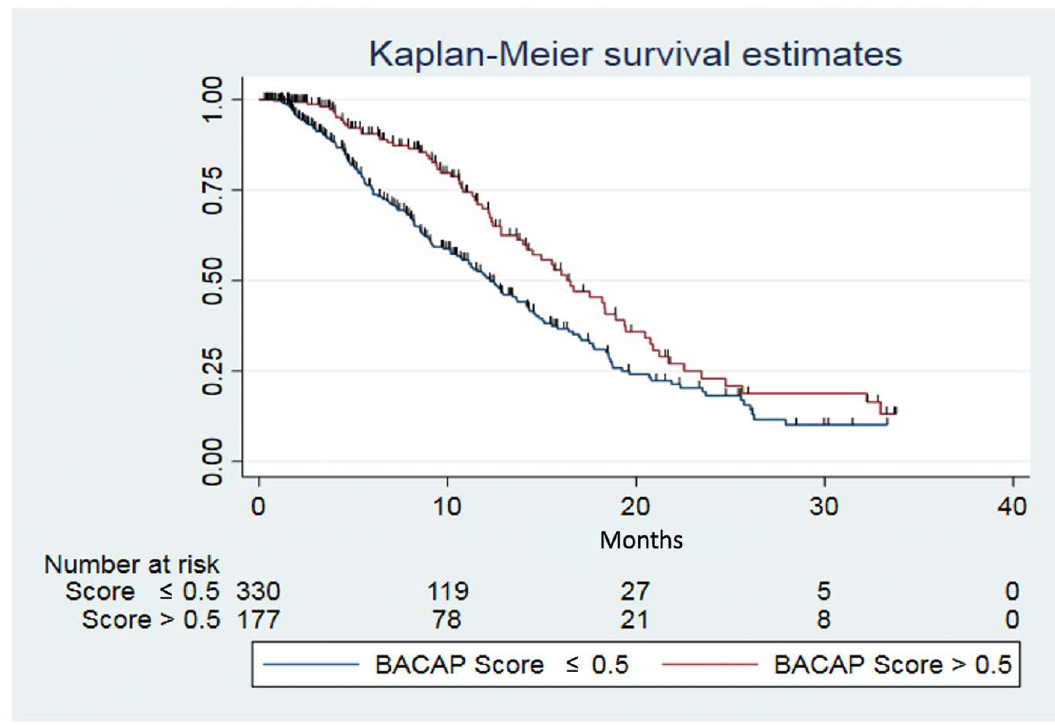
Figure 3. Kaplan–Meier survival estimates according the BACAP score. Log-rank test ( p = 0.0012).